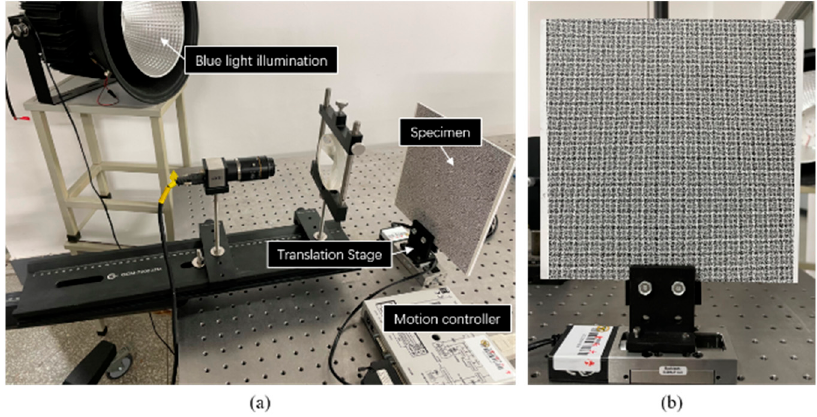
10 of 15 Figure 10. Comparisons of displacement standard deviation in static experiment between case VIEW-12 (results obtained from camera1 and camera2) and case VIEW-1234 (results obtained from four cameras): ( a ) DX; ( b ) DY; ( c ) DZ. The translation experiment con fi guration is shown in Figure 11a. A translation stage (Newport, MFA-CC) controlled by a motion controller (Newport, SMC100) drove the specimen to move in a set direction. The specimen and the translation stage are shown in